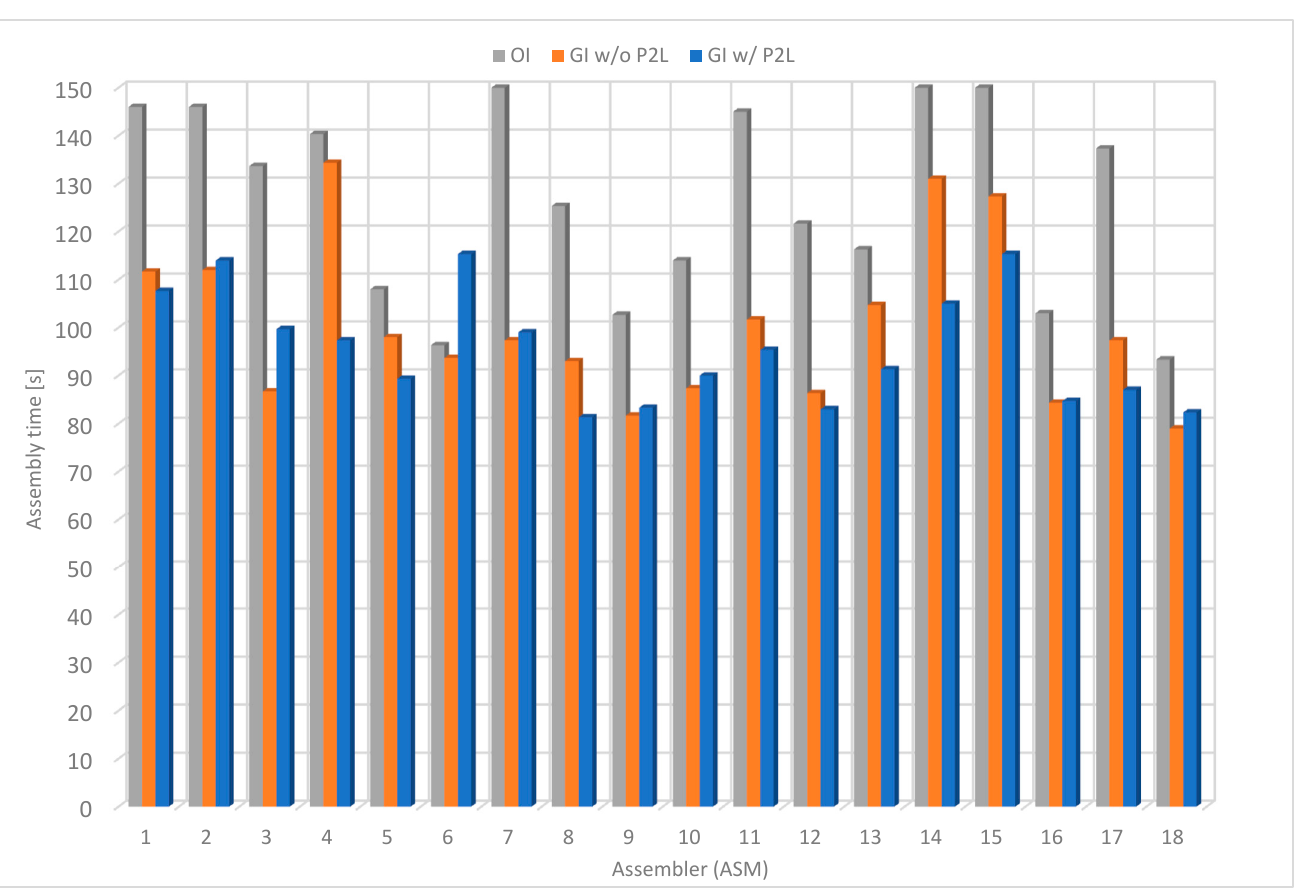
Figure 19. Average assembly time.